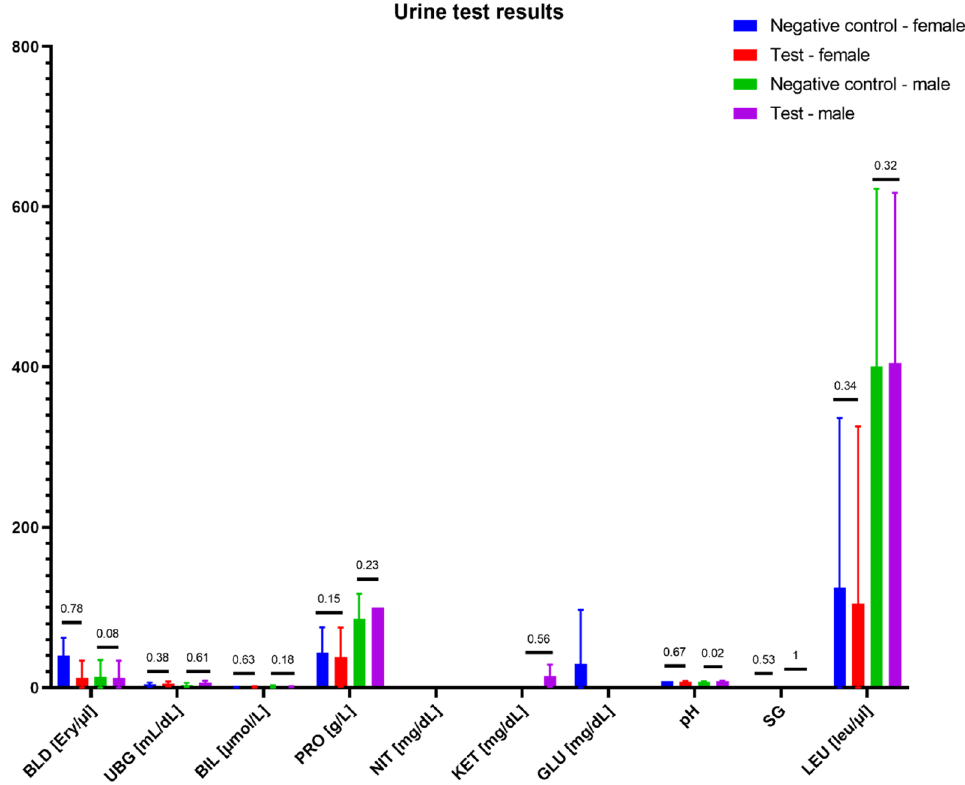
Figure 10. Urine test results. Statistically significant differences were observed in urine pH between the control and test group of male rats. However, the difference did not impact the clinical status of the animals. No other statistically significant differences were observed among the remaining parameters.